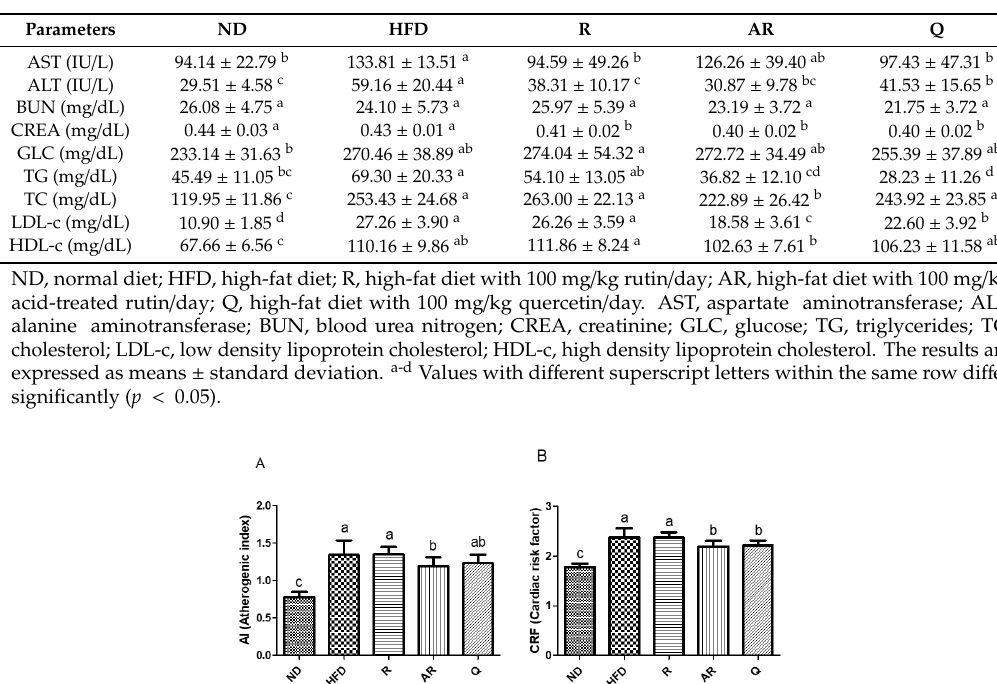
Table 5. Effect of experimental diets on plasma biochemical parameters in mice. Parameters Table 5. E ff ect of experimental diets on plasma biochemical parameters in mice.